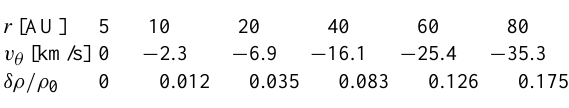
Table 1. Estimated latitudinal solar wind speeds v θ in [km/s] as a function of the solar distance r in [AU] along an off-upwind radian with latitude of θ ’ 15 ◦ .